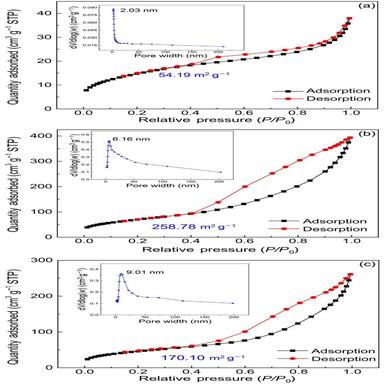
(Color online) Nitrogen adsorption-desorption isotherms of NiO (a), NiO@NiMoO4 (b) and NiO@NiMoO4@PPy (c). Insets are pore size distribution curves of three samples.